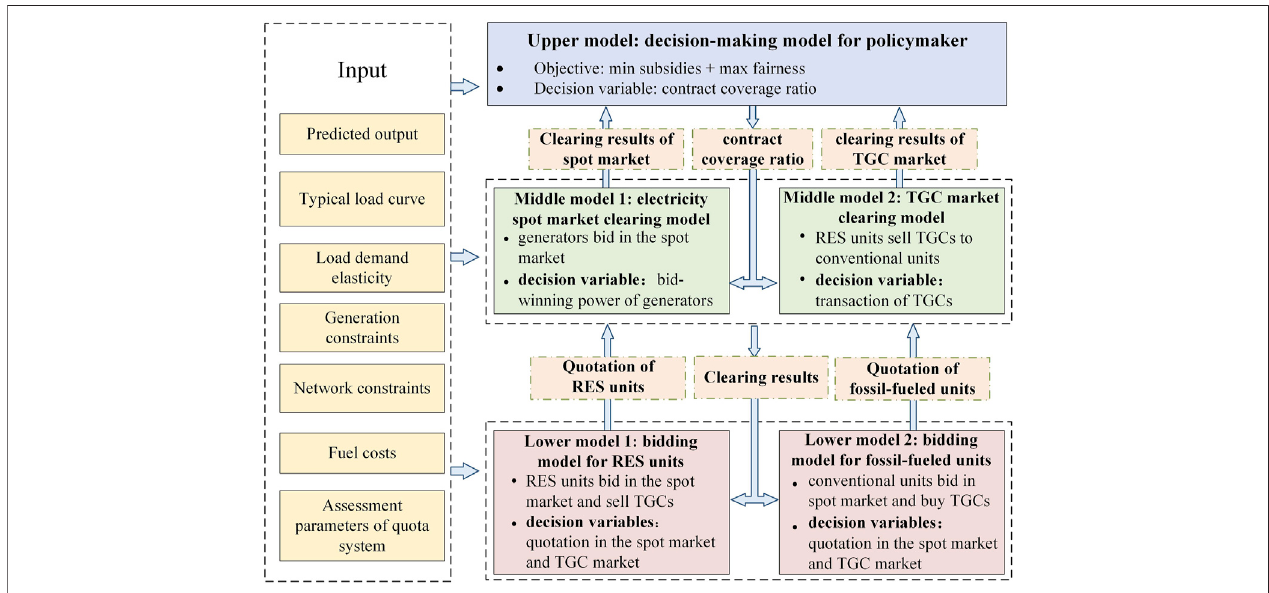
FIGURE 2 | Illustration of the three-layer optimization model for determining the